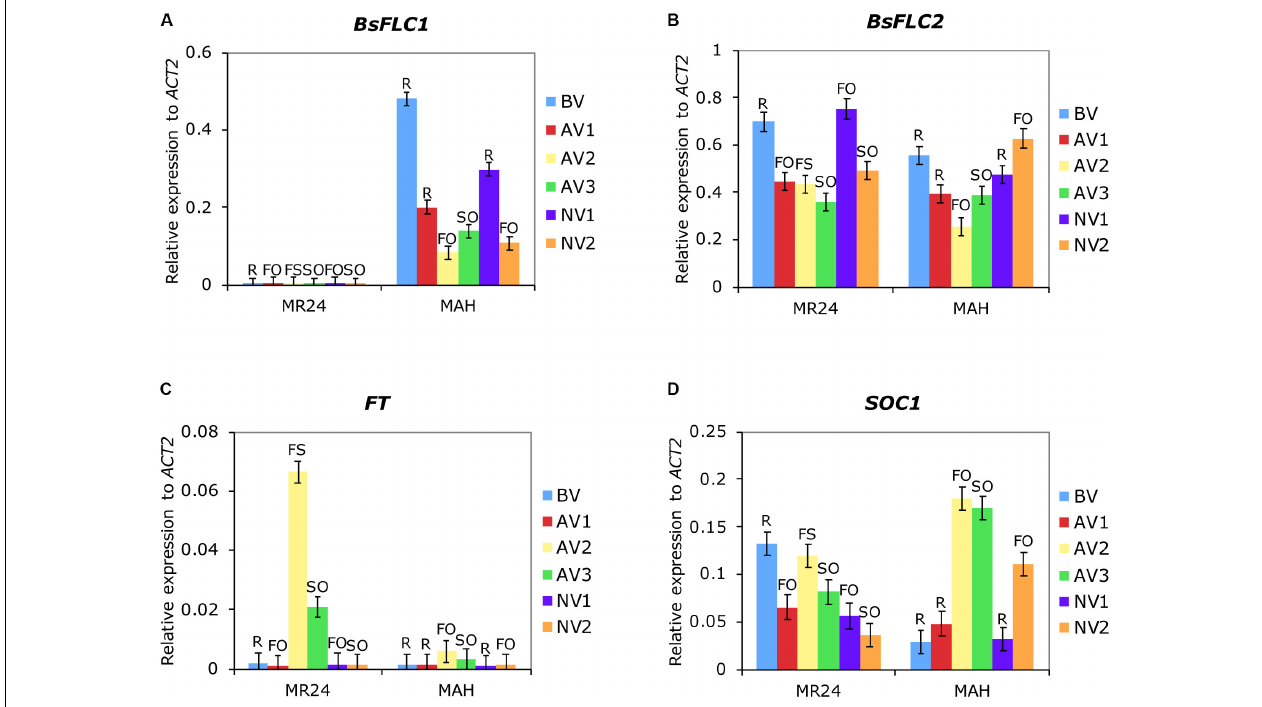
FIGURE 4 | Expression patterns of four flowering-related genes (A) BsFLC1 , (B) BsFLC2 , (C) FT , and (D) SOC1 . Shown are the means and standard errors of relative expression to reference gene ACT2 from two parental accessions and six time points. For each graph, the horizontal axis first separates the two accessions (MR24/MAH) then the six time points (BV to NV2: BV – before vernalization, 7-week plants. NV1 – no vernalization group 1, 9-week plants. NV2 – no vernalization group 2, 18-week plants; AV1 – after vernalization group 1, 1 week after vernalization; AV2 – after vernalization group 2, 3.5 weeks after vernalization; AV3 – after vernalization group 3, 6 weeks after vernalization. Detailed timeframe in Supplementary Figure S1). Capital letters above each bar represent the stage of experimental plants (R, rosette; FO, flowers only; FS, with flowers and siliques; SO, siliques only).